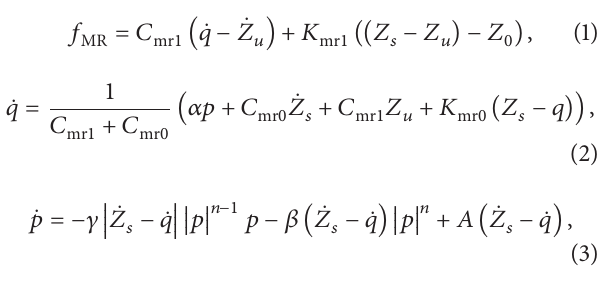
Figure 1. The governing equations of Spencer MR